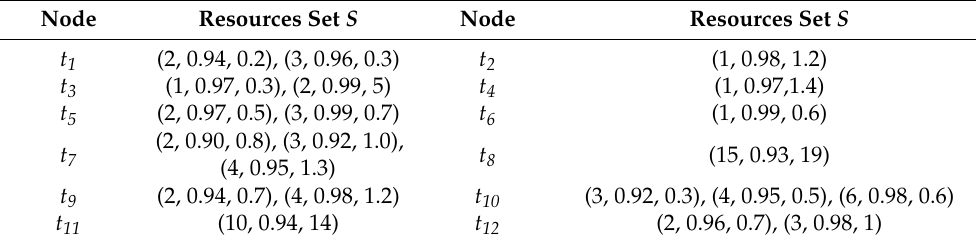
Table 2. Nodes and corresponding resource set.